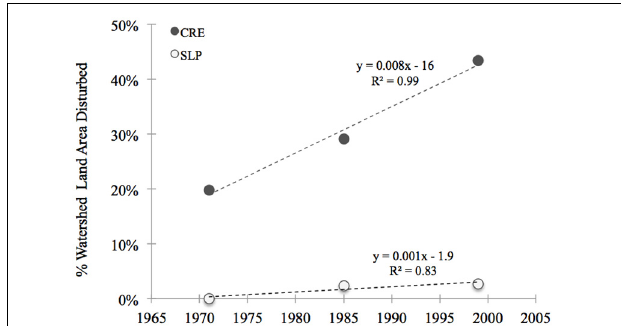
FIGURE 2 | Thirty years of land use/land cover change in two Waquoit Bay sub-watersheds, Childs River Estuary (CRE, closed gray circles) and Sage Lot Pond (SLP, open circles). Disturbed areas were defined as regions under high human influence. This included the following land use categories (data from MassGIS, www.mass.gov): residential, commercial, industrial, transportation, waste disposal and cropland. Equations and the coefficient of determination ( R 2 ) for linear models are displayed next to the